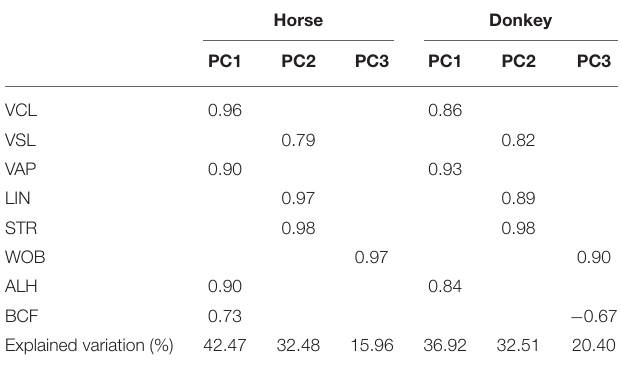
TABLE 2 | Eigenvectors of the three principal components obtained in the study of sperm kinematics for horse and donkey. Horse